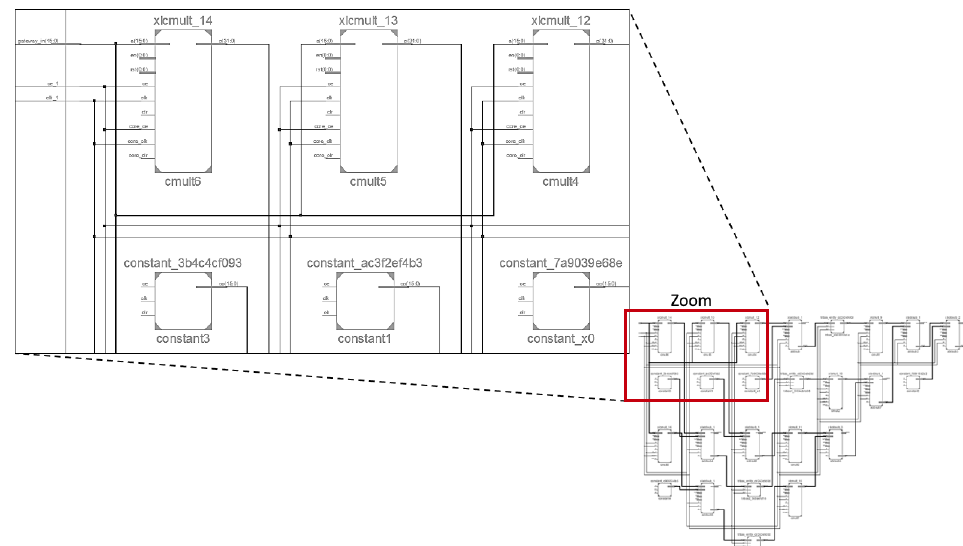
Figure 10. A zoom on NN AM/PM